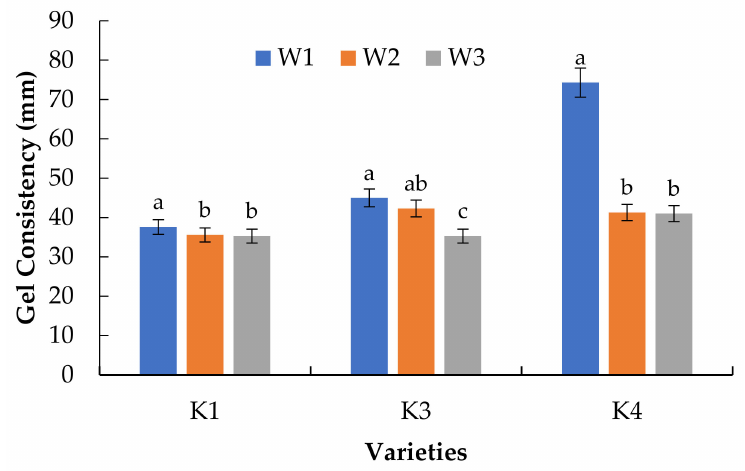
Figure 3. Rice gel consistency under water deficit. W1, continuous flooding; W2, 2-day irrigation interval; W3, 3-day irrigation interval. Values with similar letters are not significantly different ( p <